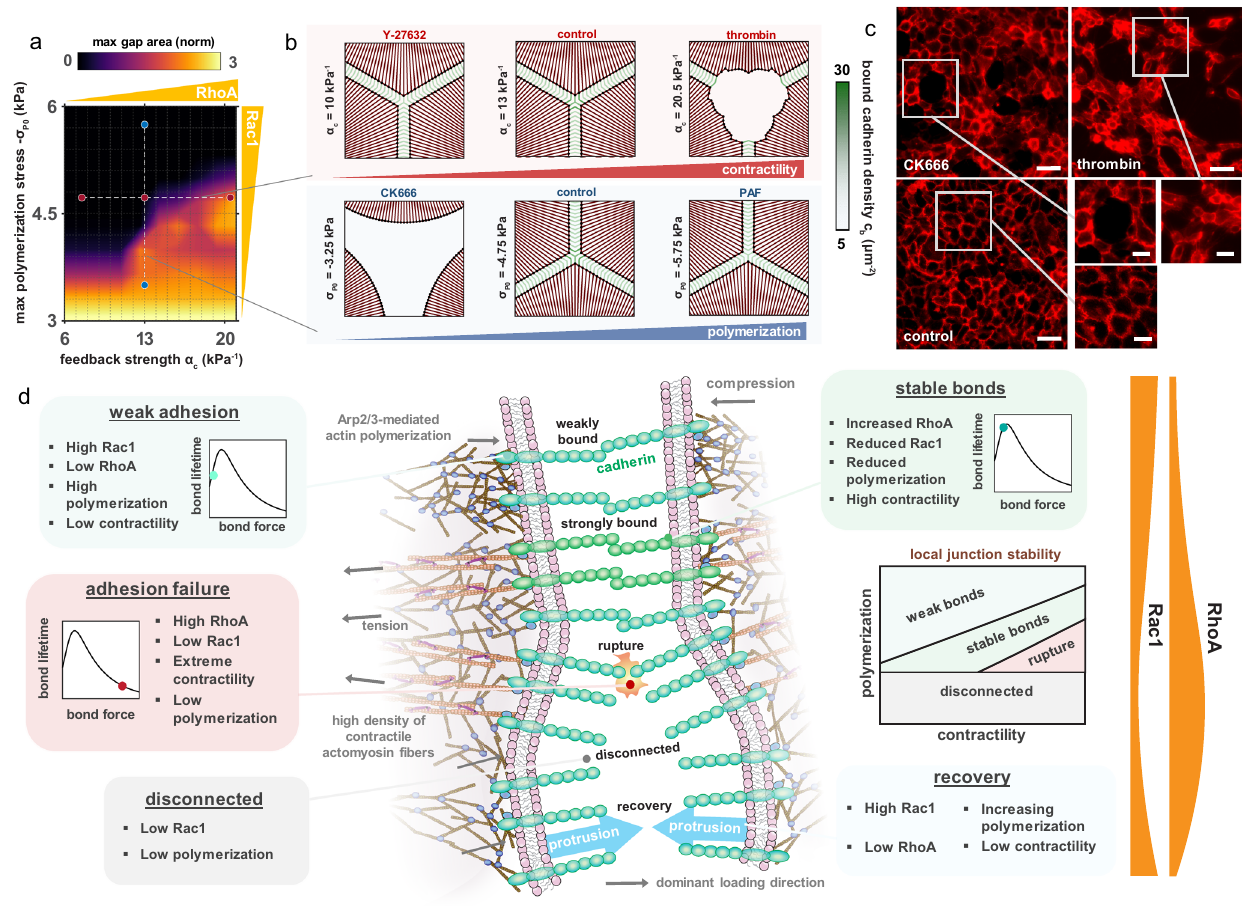
Fig. 6 | Junction state is governed by RhoA and Rac1 signaling. a Maximum monolayer in response to pharmacological treatment with thrombin or CK-666. Scale bar, 50 μ m . Red fl uorescence shows CD31. Inset scale bar, 25 μ m ; ( d ) A predicted gap size as a function of feedback strength α c and maximum balance of RhoA and Rac1 signaling is essential to the maintenance of endothelial (area normalized by maximum area under polymerization-induced stress σ P 0 junctions with variations driving junction weakening or control conditions); ( b ) Predicted in fl uence of pharmacological treatments on junction stability and gap formation. Scale bar, 25 μ m ; ( c ) Organization of HUVEC